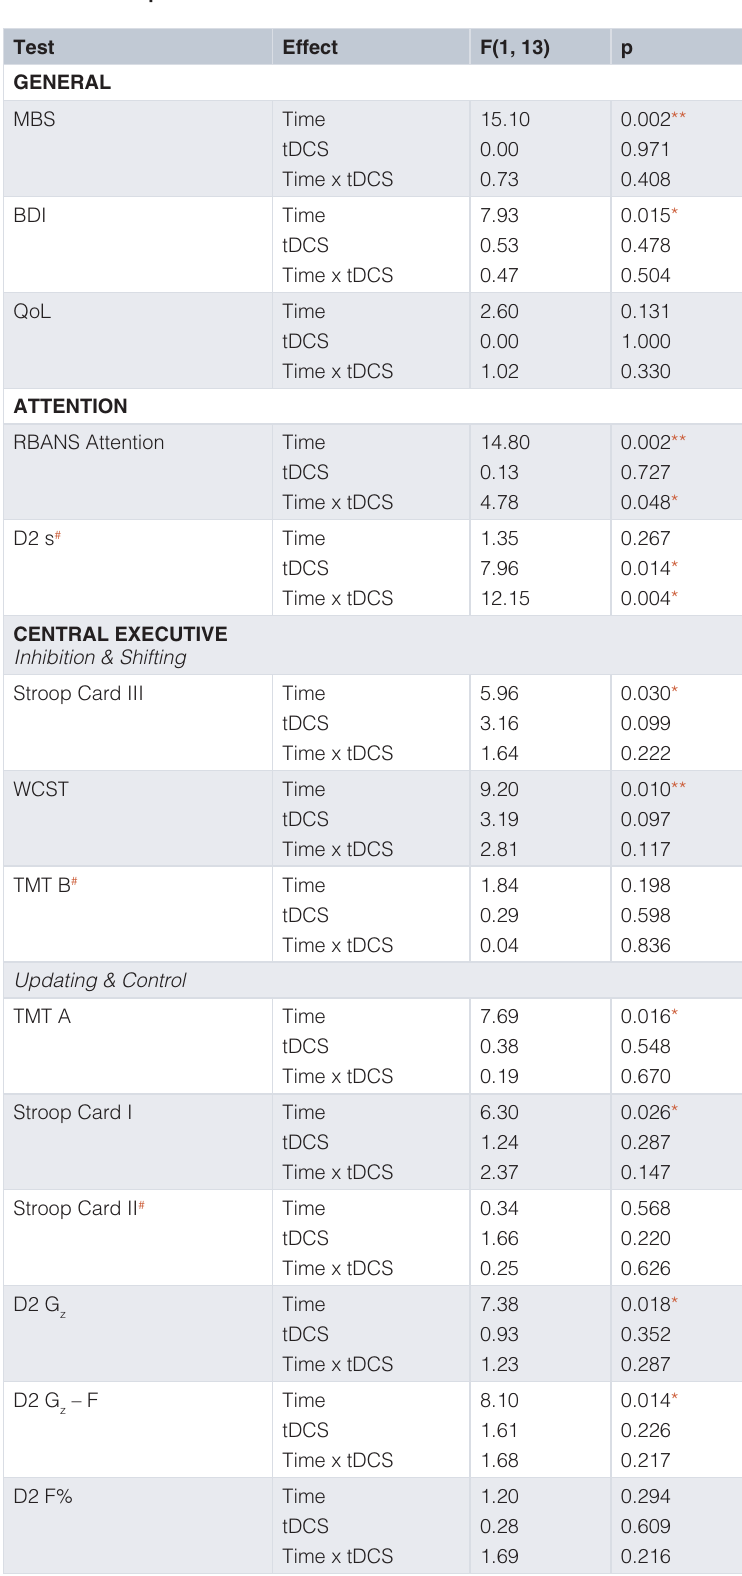
Table 7. F- and p-values for the linear mixed